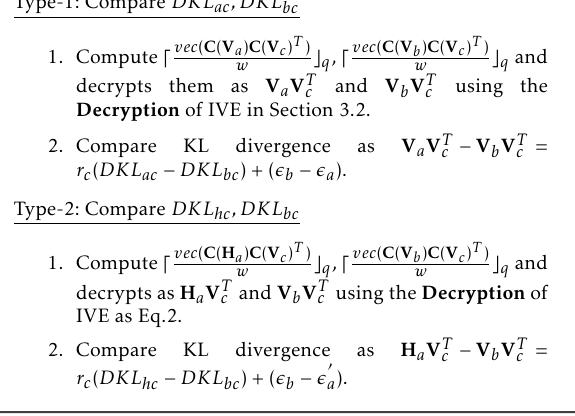
Figure 4. Construction of